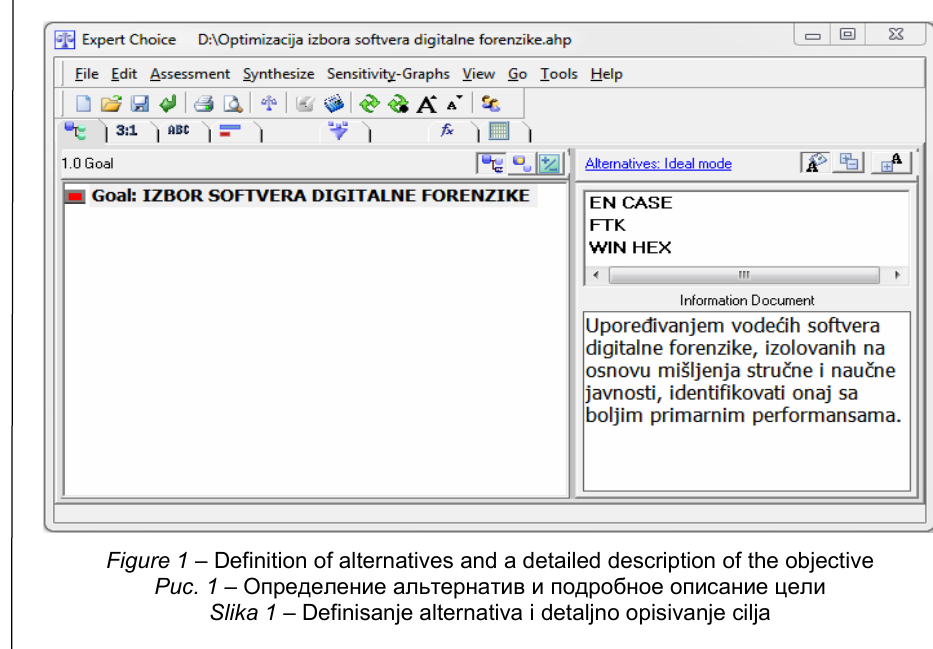
Figure 1 – Definition of alternatives and a detailed description of the objective Рис . 1 – Определение альтернатив и подробное описание